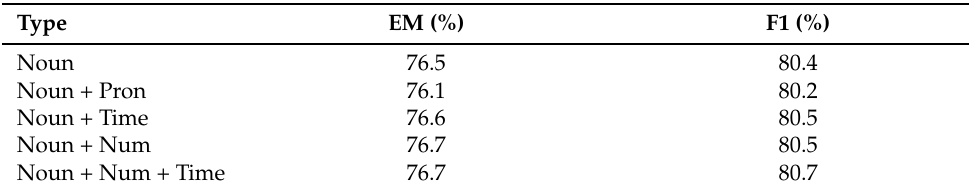
Table 6. Impact of the POS on the performance of the